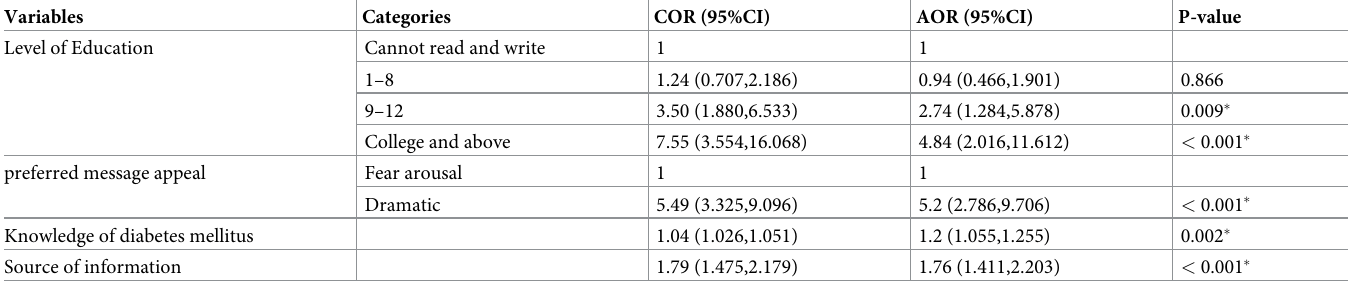
Table 8. Predictors of Response to self-care message among patients with diabetes visiting Jimma University medical center Ethiopia, April 12- May 25, 2020.